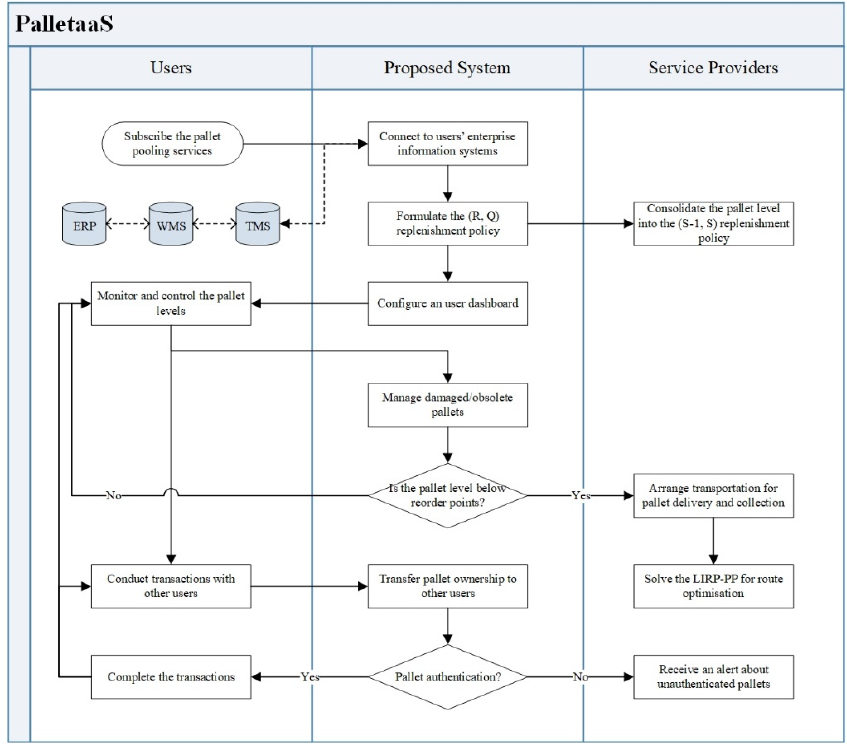
Figure 5. Human–computer interaction of the proposed system.